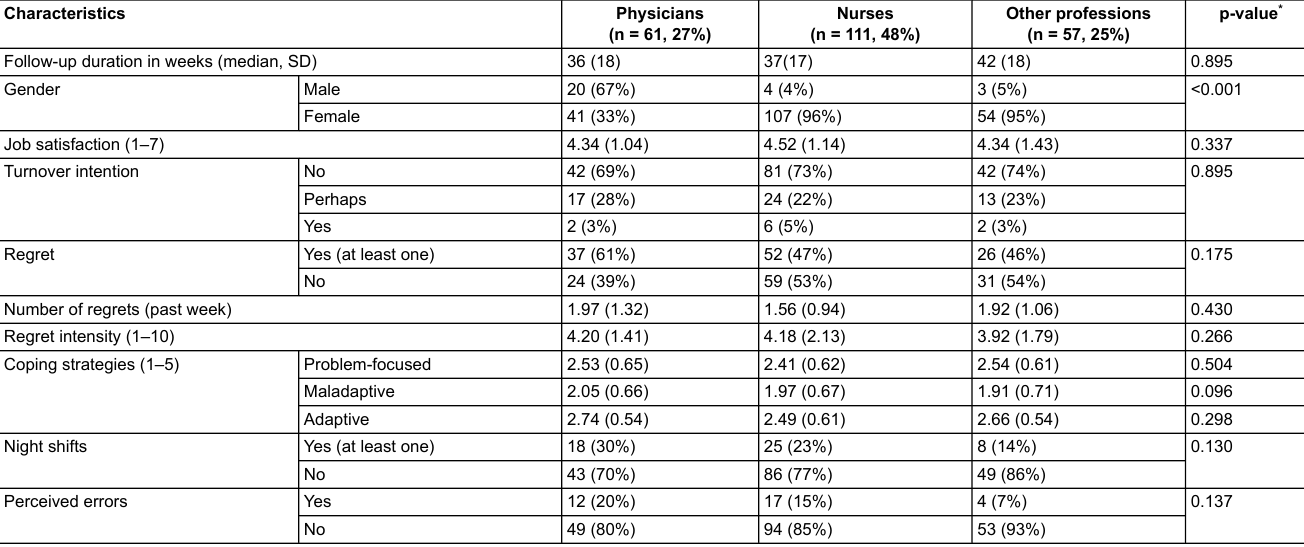
Table 1: Descriptive characteristics of the 229 healthcare professionals on the first occasion of measurement. Characteristics